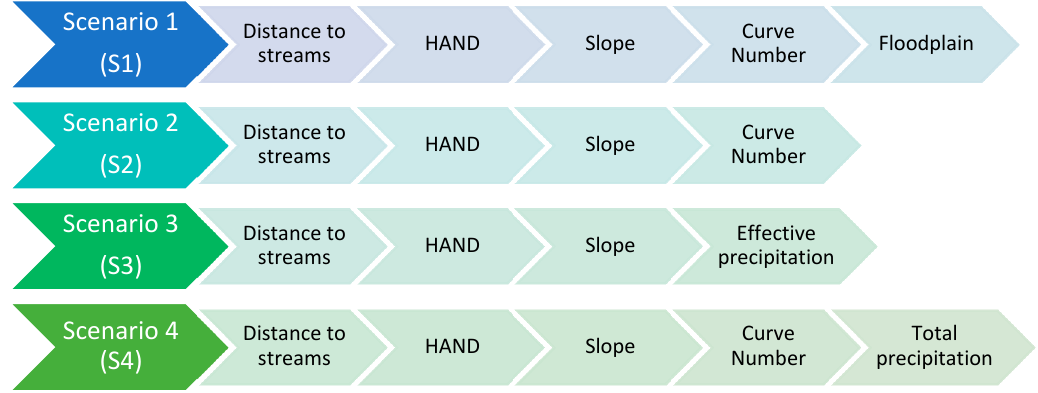
( g ) Figure 4. Flood hazard criteria reclassified; ( a ) slope; ( b ) height above the nearest drainage; ( c ) distance to streams; ( d ) Curve Number; ( e ) total precipitation; ( f ) effective precipitation; ( g ) floodplain.